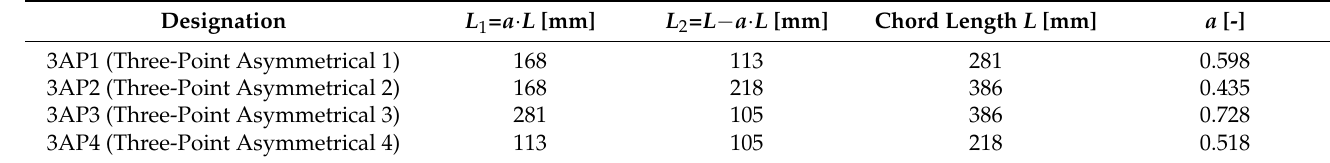
Table 1. Chord parameters for the methods integrated into the